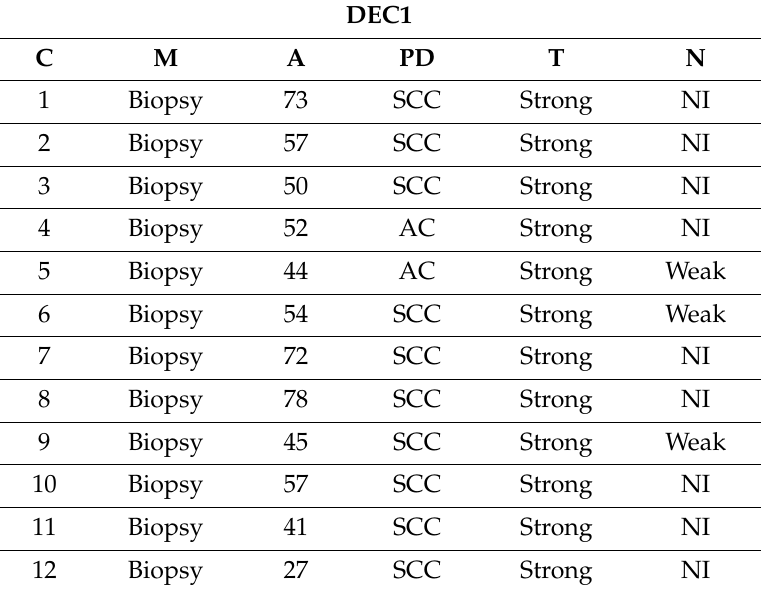
Table 1. Immunohistochemical detection of di ff erentiated embryonic chondrocyte gene 1 (DEC1) proteins in human cervical cancer